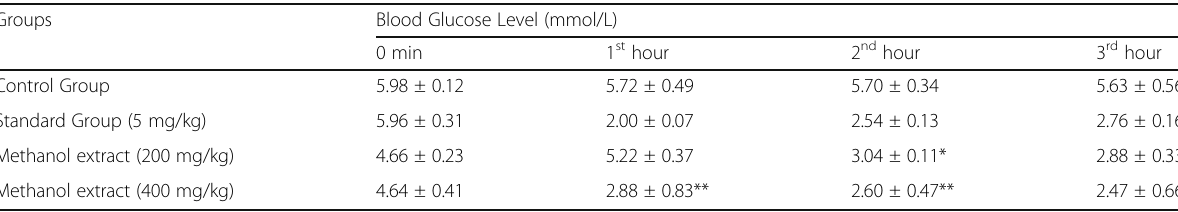
Table 7 Effect of L. speciosa flower extract on blood glucose of Swiss albino mice